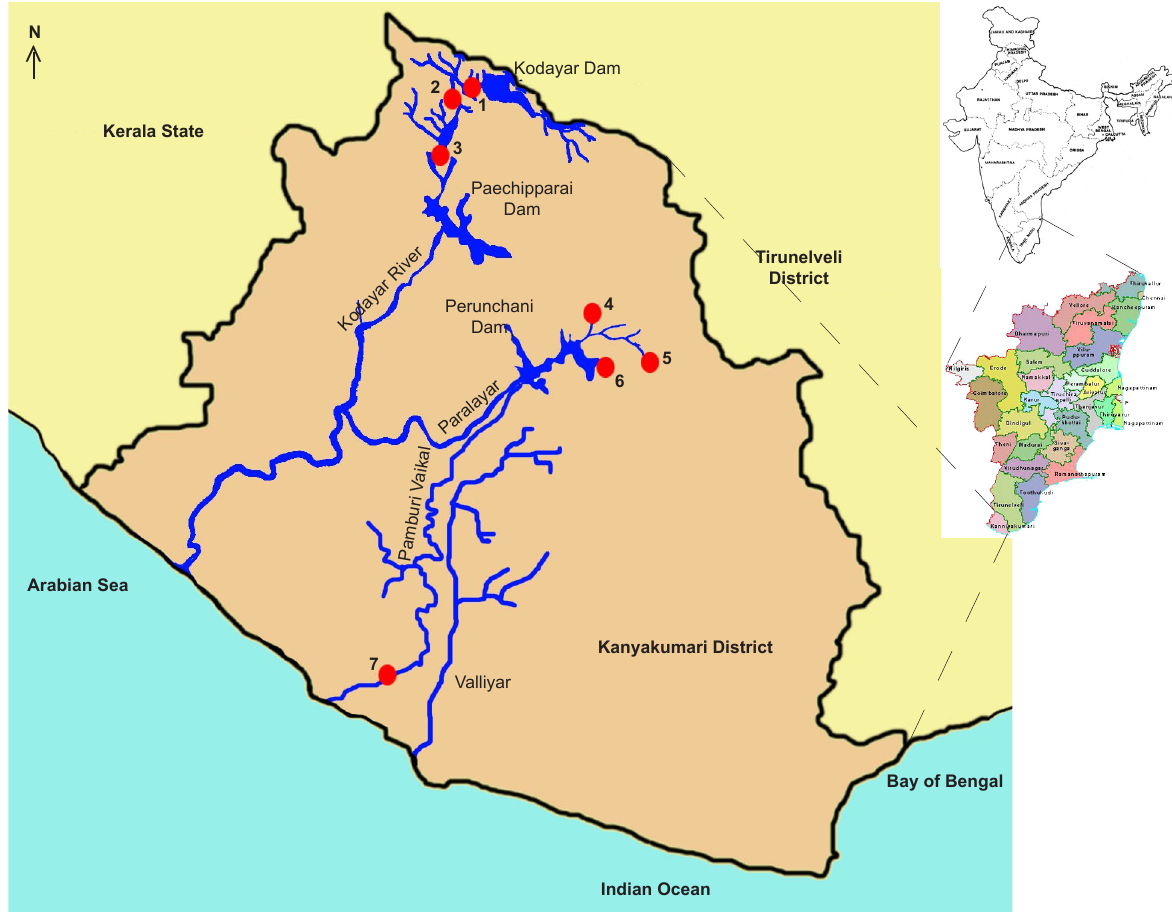
Figure 1. Principal localities in southern India from where Puntius rohani sp. nov. has been collected: 1 - Kallar; 2 - Vellachithodu; 3 - Mayilar; 4 - Kalikesam; 5 - Keeriparai; 6 - Palkulam; 7 - Manavalakurichi (map not to